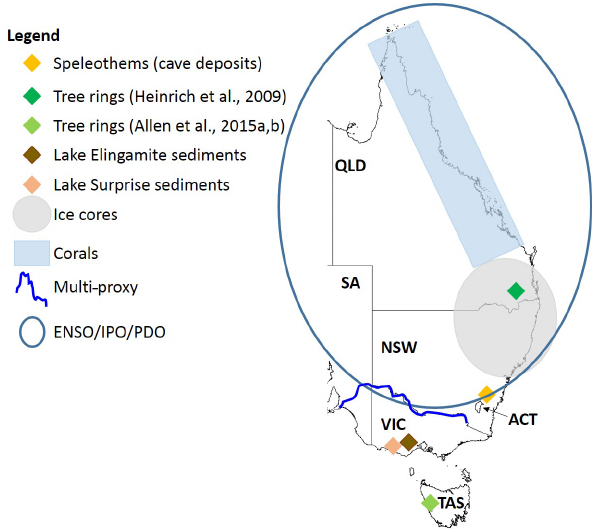
Figure 1. Location map of selected palaeoclimate reconstructions for Queensland (QLD), New South Wales (NSW), the Australian Capital Territory (ACT), Victoria (VIC), Tasmania (TAS), and South Australia (SA). For remote palaeoclimate records, the map indicates where the studies listed have found significant relation- ships/impacts, while for local records the map shows the actual lo- cation of the proxy (refer to Table 1 for further details on the local and remote palaeoclimate records used in this